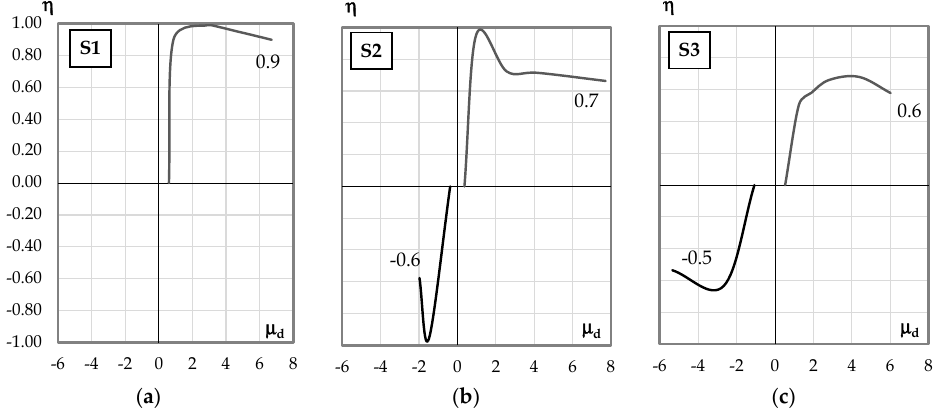
Figure 14. Absorbed energy parameter for one cycle with and without gravity load. The absorbed energy parameter, η , for a given cycle i , can be obtained with Expres- sion (3), and Figure 14 illustrates the variables involved.